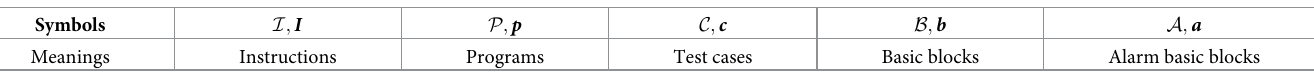
Table 1. Description of used